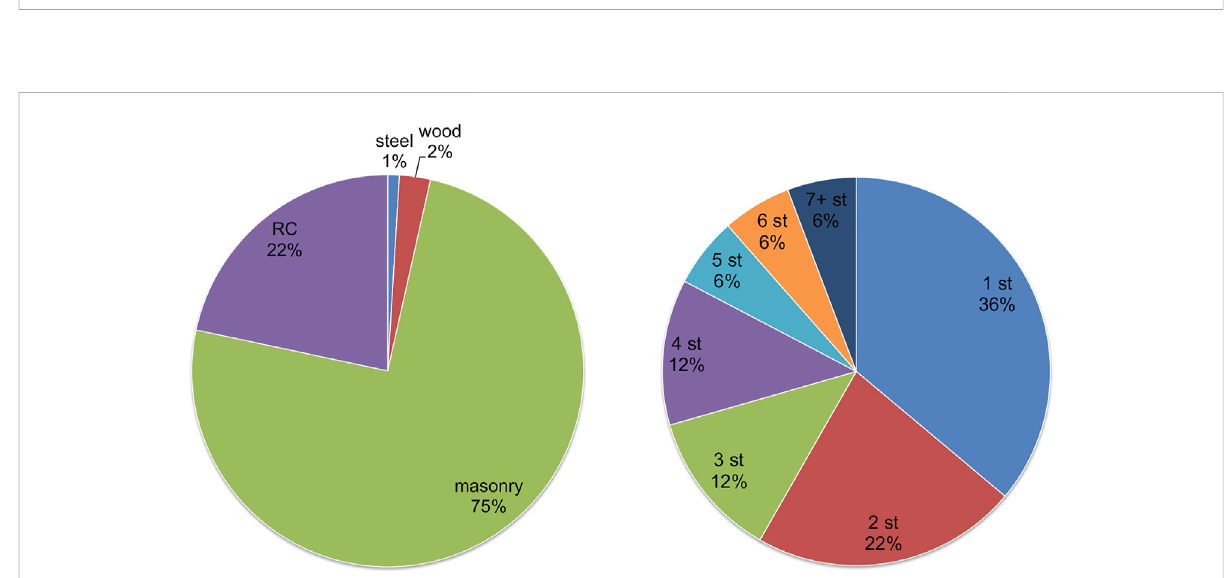
FIGURE 3 Overall distribution of building material (left) and building height (right) for Martigny (Lestuzzi et al.,